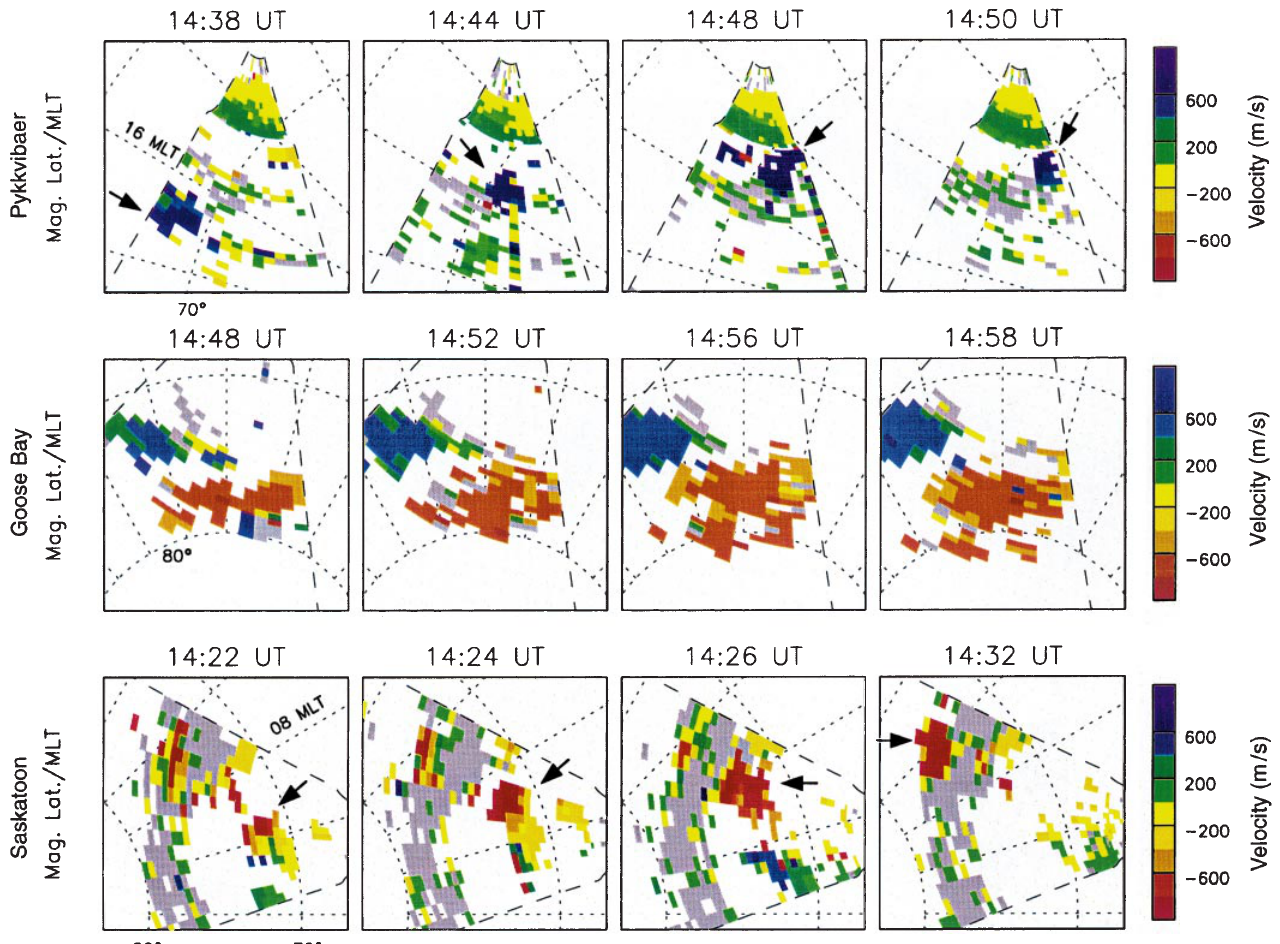
dotted lines represent 60 (cid:176) , 70 (cid:176) , or 80 (cid:176) magnetic latitude. Dashed lines indicate the extent of the radar fields-of-view. In the Pykkvibaer and Saskatoon radar panels, arrows indicate the location of the return flow